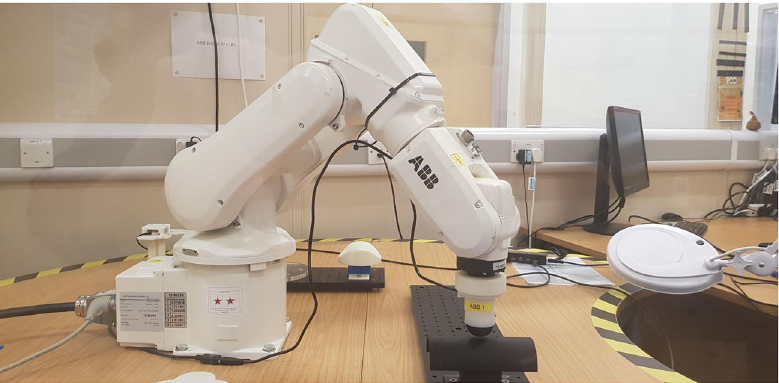
Fig. 3 A robot arm equipped with a TacTip sensor. TacTip (black semi-sphere) is developed to create a sense of touch for the robots so when the robot touches a surface of an object it can detect patterns and shapes based on deformation of the TacTip sensor. (Credit: Mehdi Sobhani).